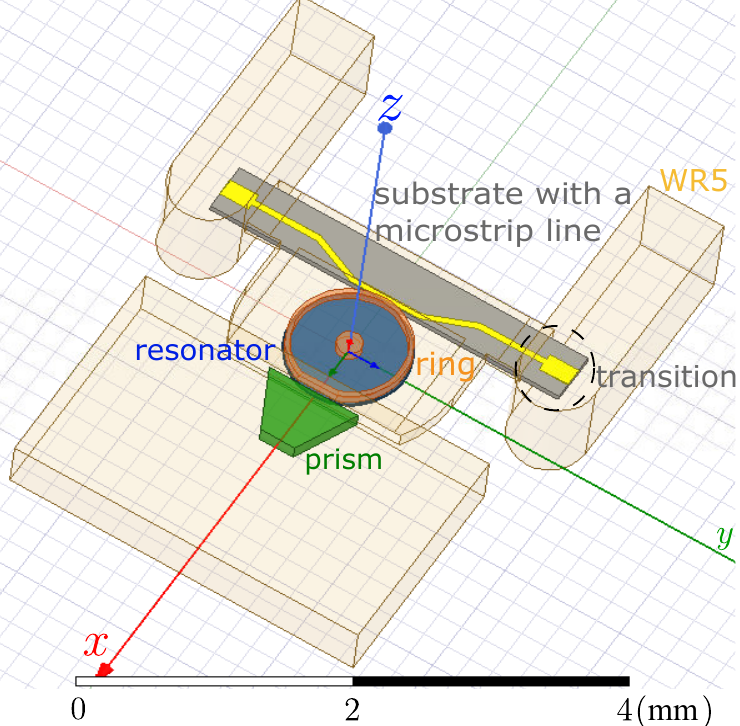
Figure 3. The upconversion scheme with microstrip and prism for millimeter-wave and optical coupling,